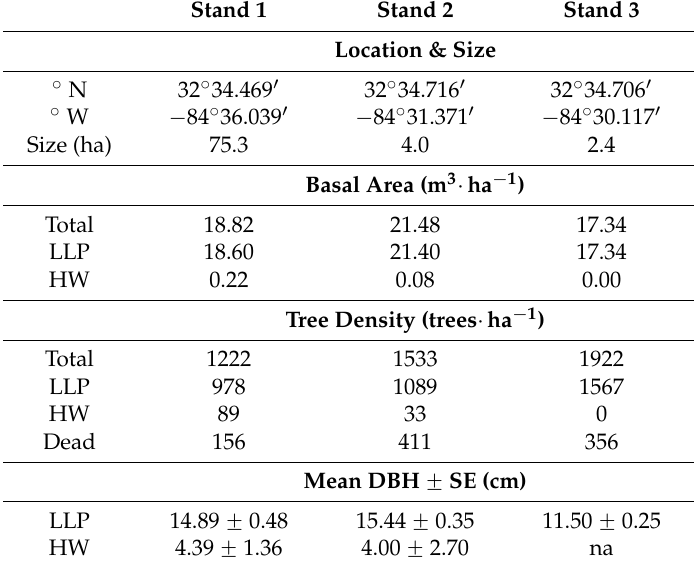
Table 1. Location and forest structural characteristics of the three 26-year-old longleaf pine (LLP; Pinus palustris Mill.) stands in Talbot County, Georgia, USA. Note: HW, hardwoods; DBH, diameter at breast height (1.37